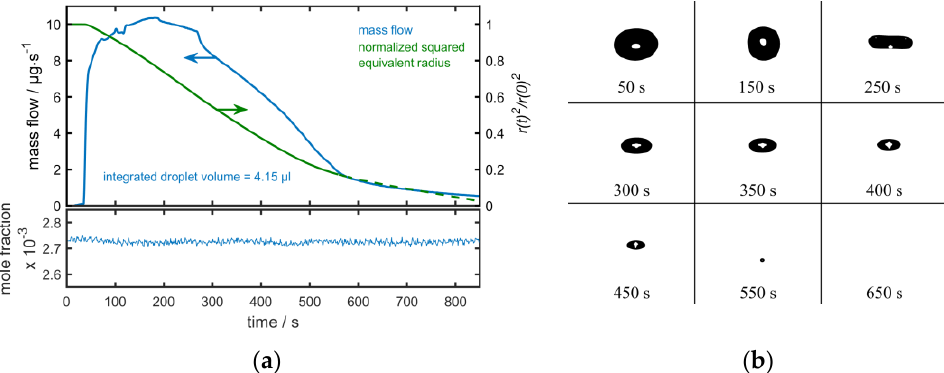
Figure 4. ( a ) Top: Measured H 2 O mass flow of a levitated pure water droplet at a drying temperature of 60 ◦ C and a nitrogen flow rate of 1.0 nL/min (blue); normalized squared equivalent radius r ( t ) 2 / r ( 0 ) 2 calculated from the initial droplet volume (green); the green dashed line (starting from 550 s) does not show the real physical behavior of the droplet radius after complete evaporation, but is only given for completeness. Bottom: Measured H 2 O mole fraction of the reference path for the monitoring of the free space Perspex chamber. ( b ) Shadowgraphy images of the levitated pure water droplet over the drying process.